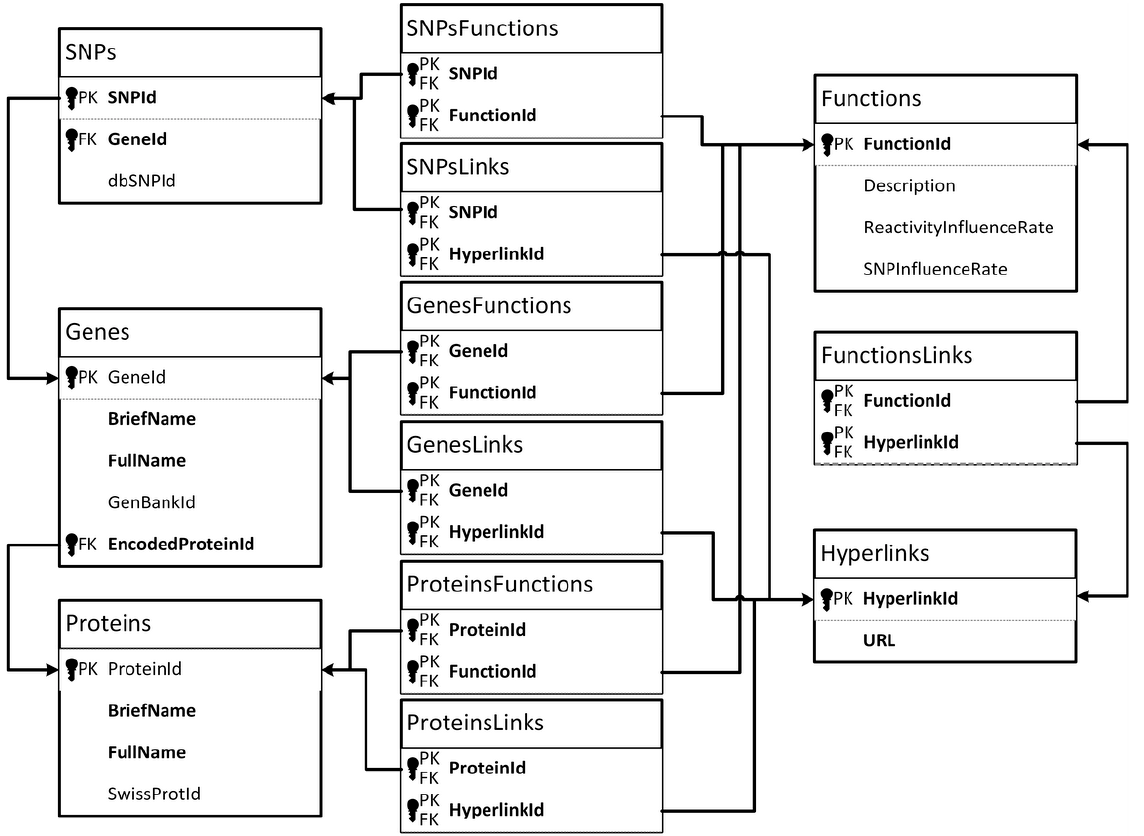
Figure 1: A block diagram of the database of genes associated with pain perception created in MS